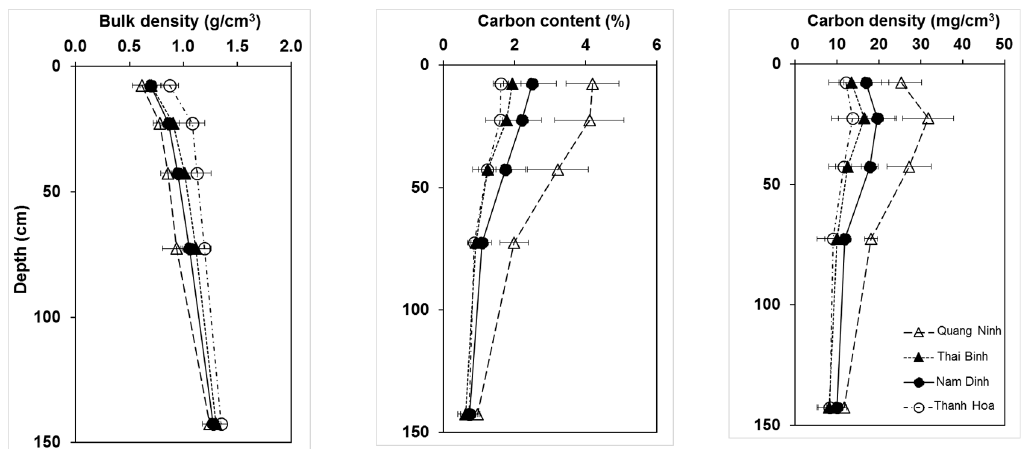
Figure 4. Soil properties according to provinces in northern Vietnam.